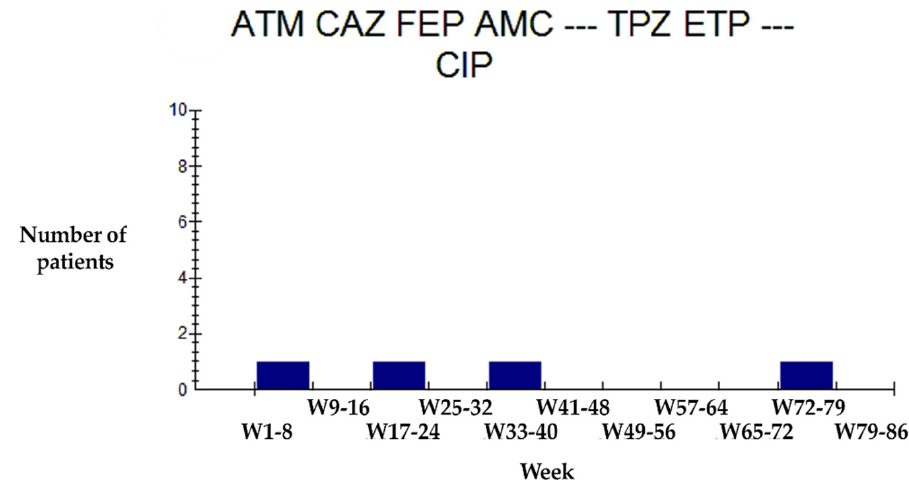
Figure 8. Evolution of the Klebsiella phenotype ATM-CAZ-FEP-AMC-TZP-ETP-CIP. Aztreonam (ATM) Ceftazidime (CAZ), Cefepime (FEP), Amoxicillin/Clavulanate (AMC) TPZ: Piperacillin/Tazobactam, Ertapenem (ETP) and Ciprofloxacin (CIP).